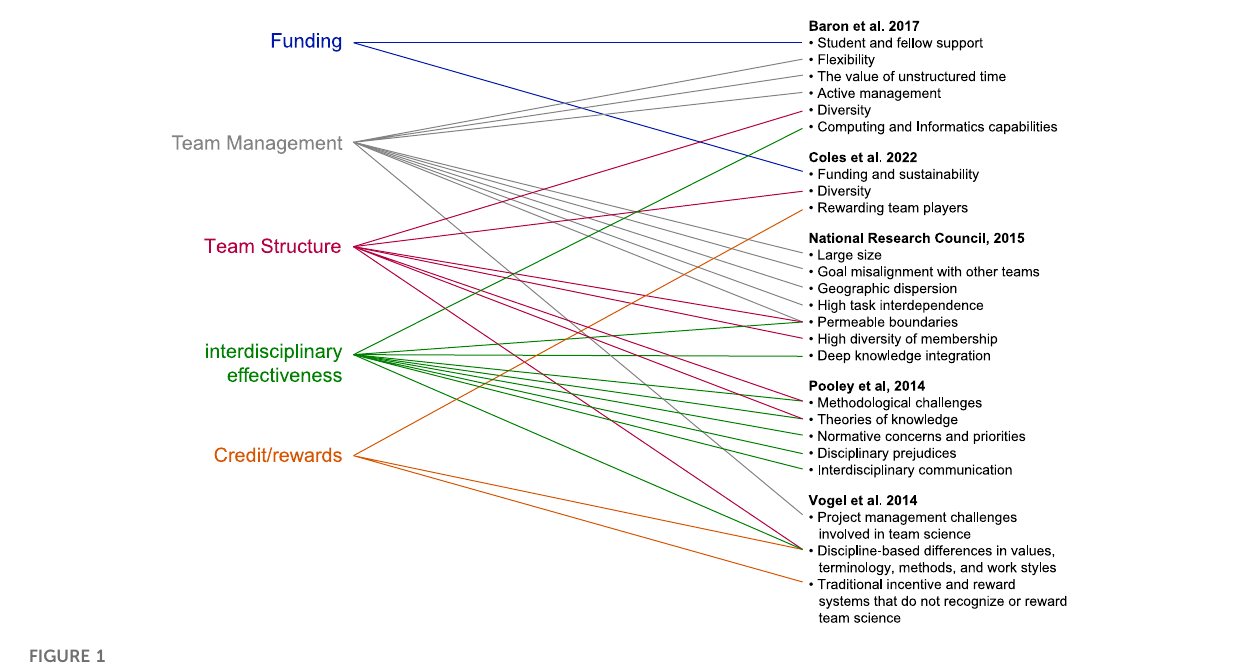
FIGURE 1 Five common challenges for science teams and the review papers that describe